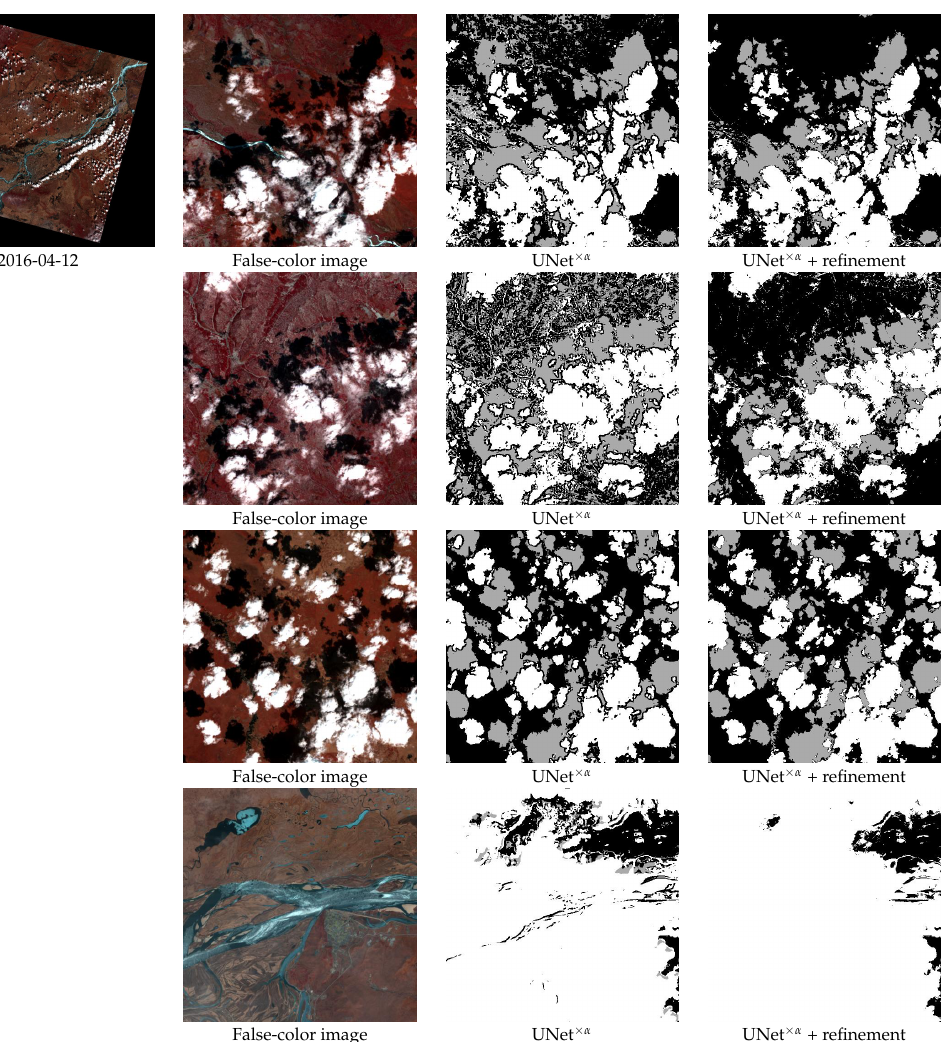
Figure 9. Comparisons of segmentations with or without Dense CRF refinement in local areas (L8, Path 113, Row 26). From left to right are false-color images, results of UNet × α , and UNet × α + Refinement. Bands 5 NIR, 4 Red, and 3 Green are combined together as RGB channels to construct a false-color image for visualization. In local areas, it is confirmed that the refinement of Dense CRF can precisely delineate the contours of clouds and shadows; in addition, it can remove the isolated classification errors and smooth the gaps caused by slice-wise